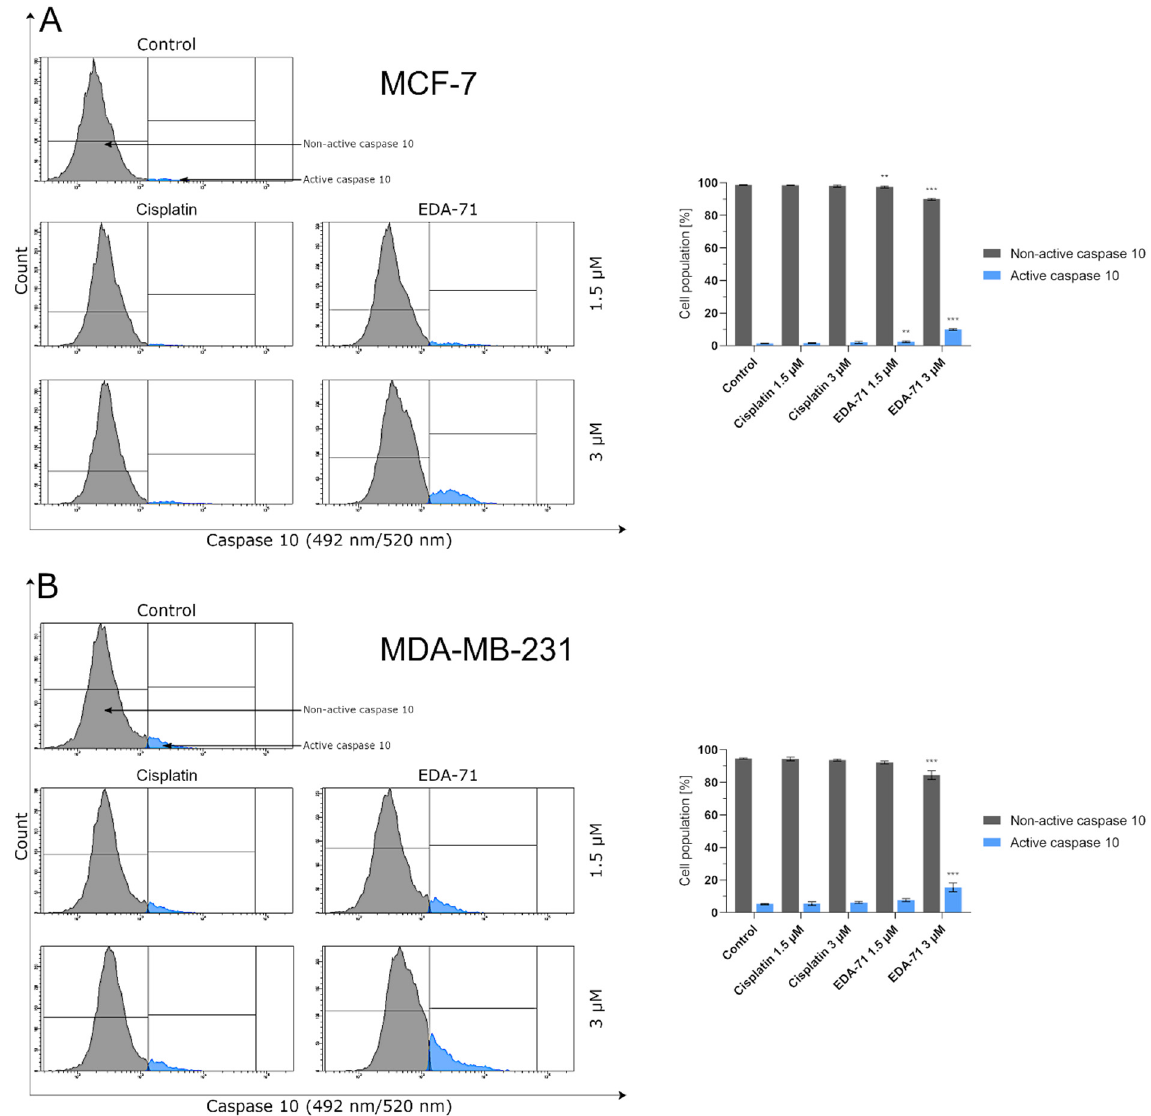
Figure 6. Cytometric analysis of caspase 10 activity in MCF-7 ( A ) and MDA-MB-231 ( B ) breast cancer cells after 24 h incubation with EDA-71 and cisplatin (1.5 and 3 µ M). Results are presented as mean values ± SD obtained from three independent experiments ( n = 3) conducted in triplicate. Statistical differences between the experimental (treated cells) and control (untreated cells) groups were determined using one-way ANOVA followed by Dunnett’s test. ** p < 0.01 vs. control group, *** p < 0.001 vs. control group.